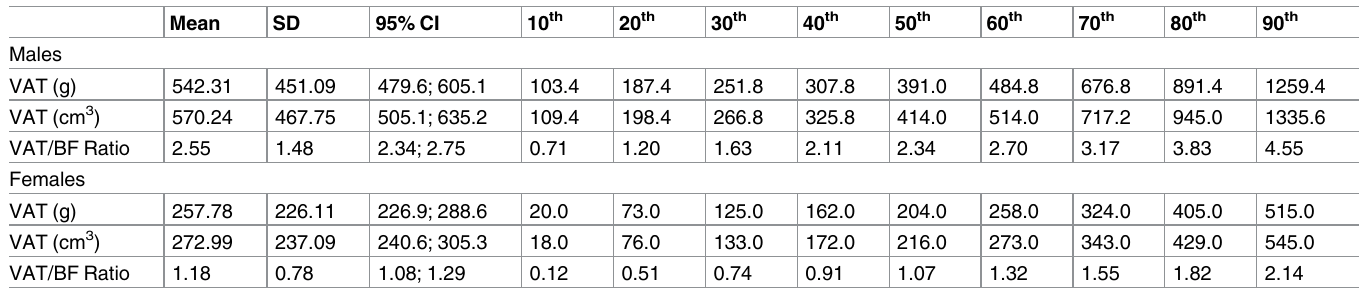
Table 2. Sex-specific percentiles of VAT and VAT/BF ratio.